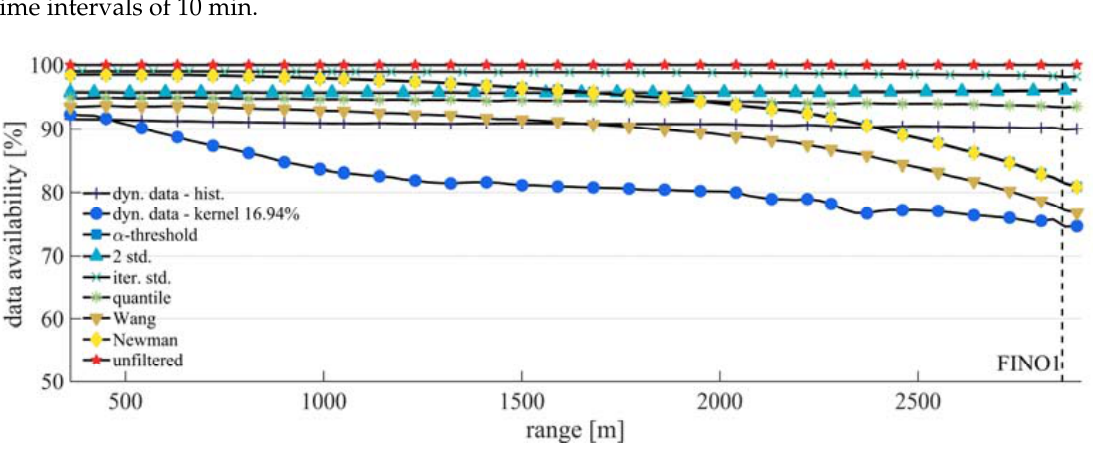
Figure 10. Data availability of staring mode measurements for different filter methods. ( a ) time dependent behaviour for range at 2864 m and ( b ) averaged data availability over all ranges. The dashed line marks the distance of the anemometer at FINO1.